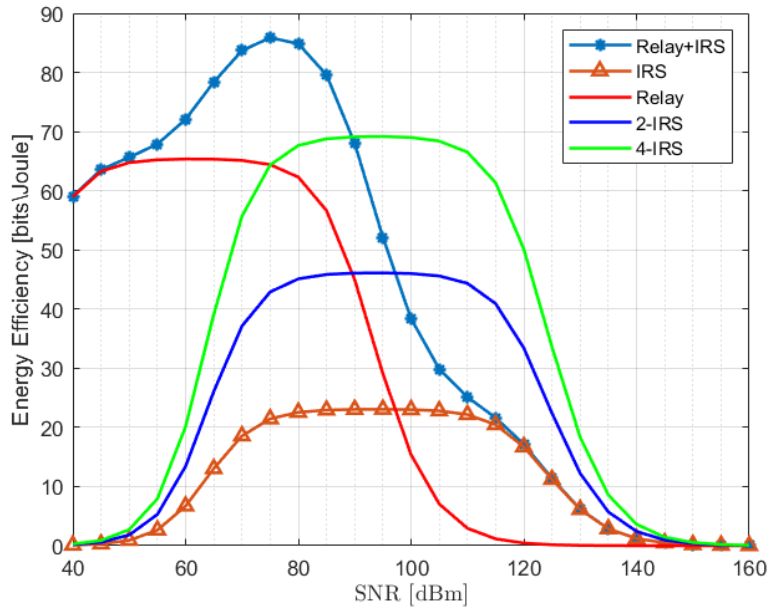
Figure 8. EE versus SNR with multiple